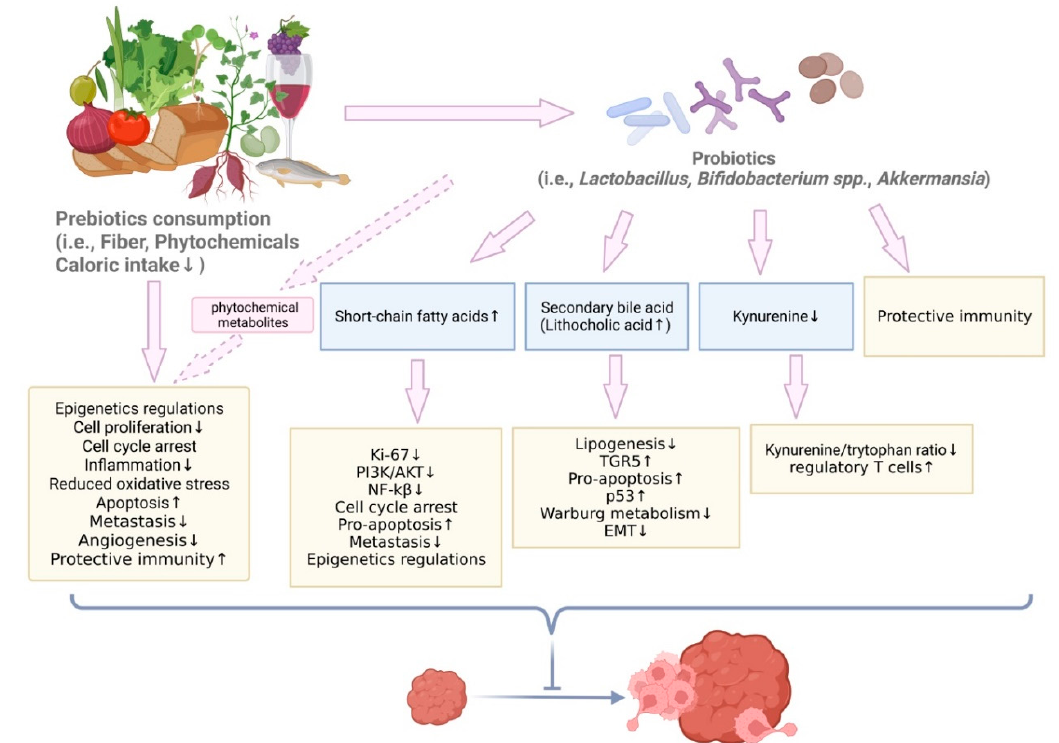
Figure 3. Prebiotics and dietary supplements having prebiotic effects in BC. Prebiotics consumption increased fiber and bioactive phytochemicals levels in situ and promoted the growth of probiotics. Tumor size, weight, metastasis, and EMT were reduced by protective bacterial metabolites, reduced pro-inflammatory status, up-regulated tumor-suppressor genes, and inhibited tumor cell prolifera- tion.